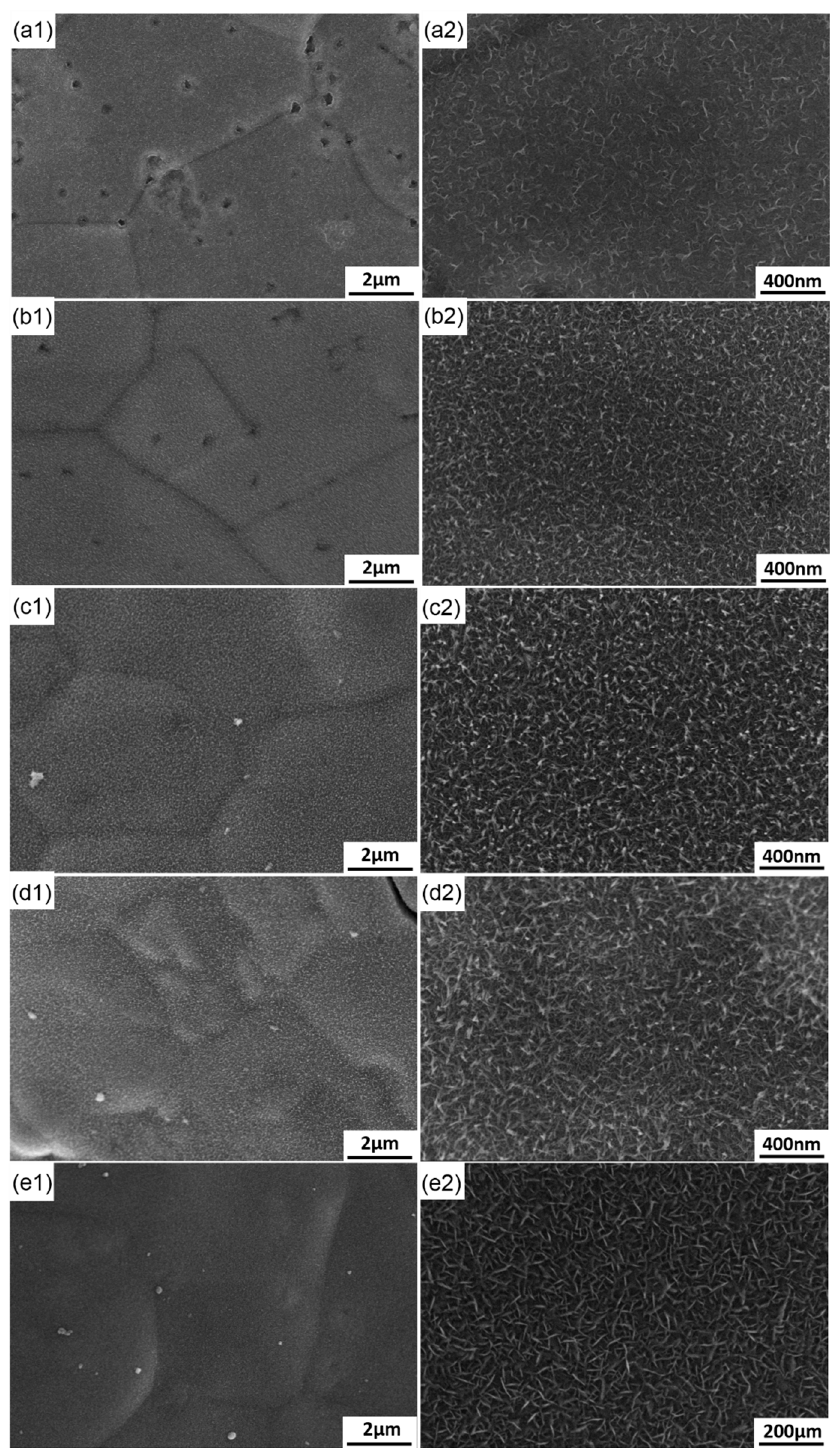
Figure 11. The morphological evolution of the deposits. ( a ) 3 s; ( b ) 7 s; ( c ) 20 s; ( d ) 40 s; ( e ) 120 s.